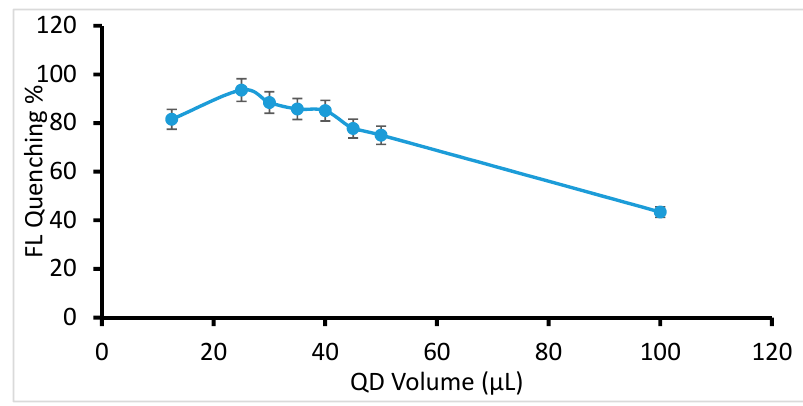
Figure 1. Effect of QDs concentration on fluorescence quenching by verapamil HCl.